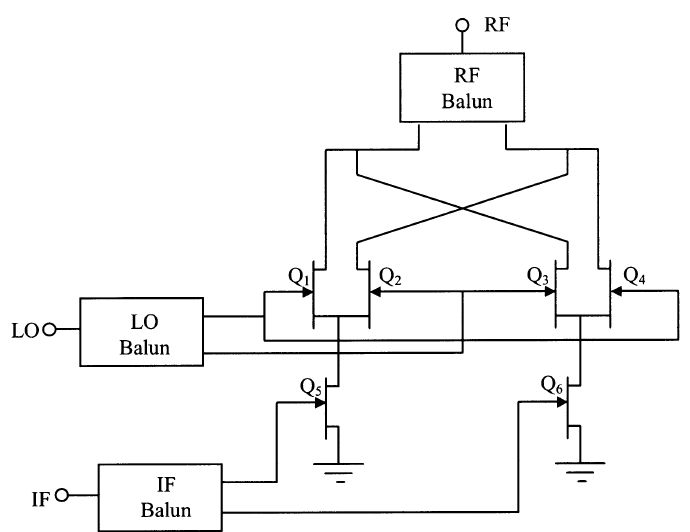
FIGURE 18 Doubly balanced pHEMT mixer using